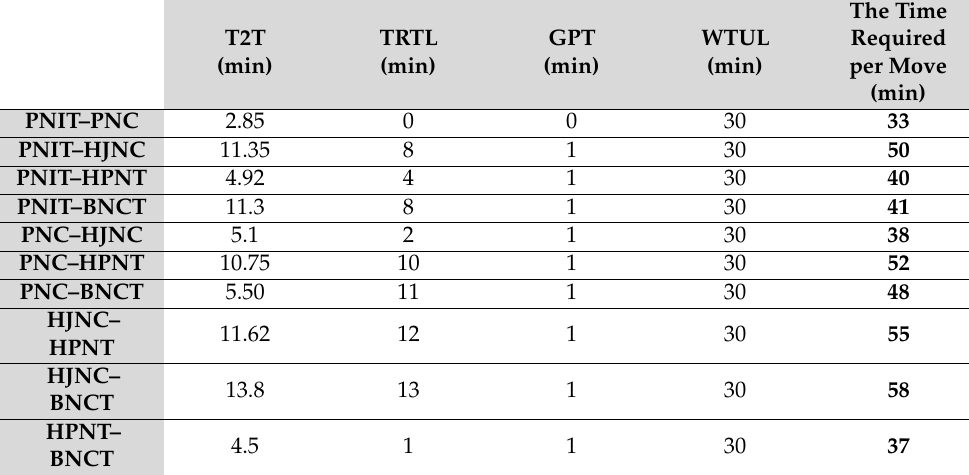
Table 4. Estimated container processing times per move [28].